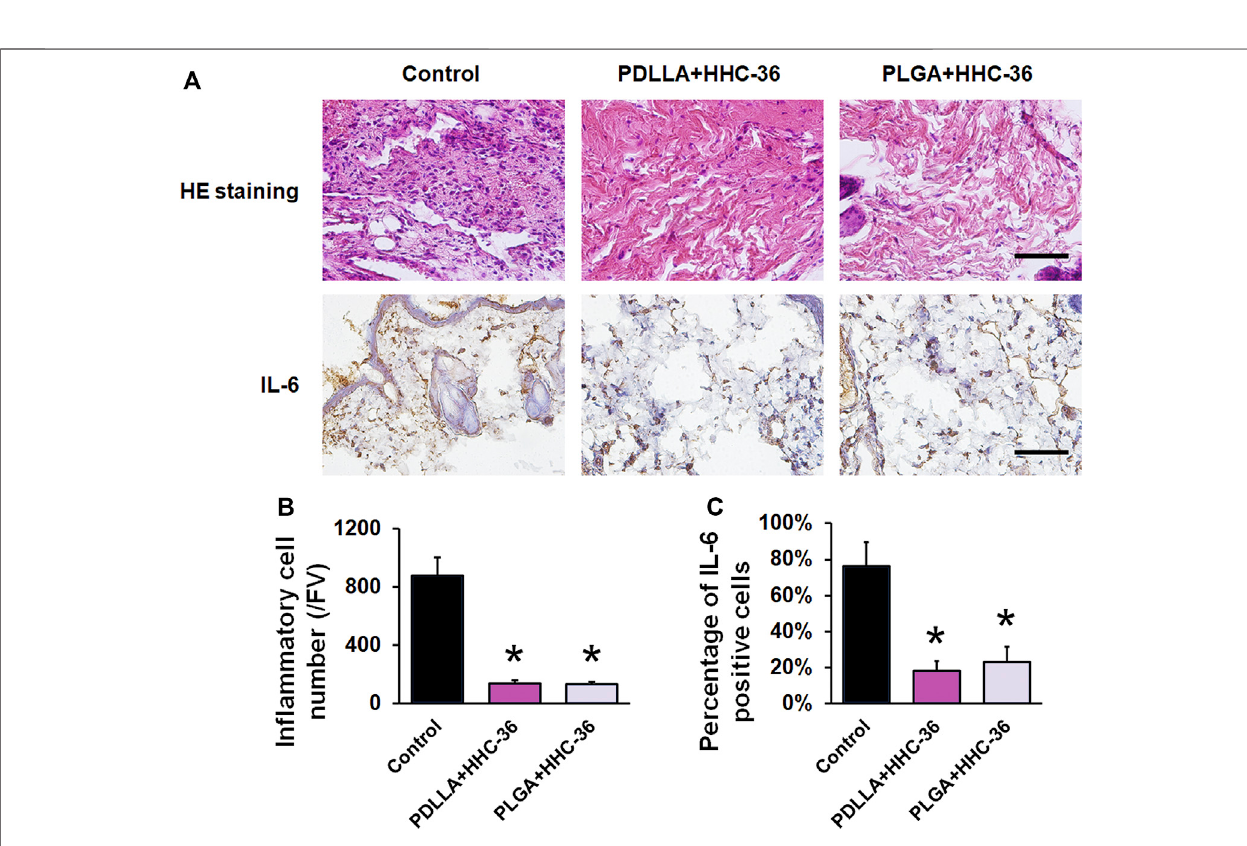
Frontiers in Bioengineering and Biotechnology |